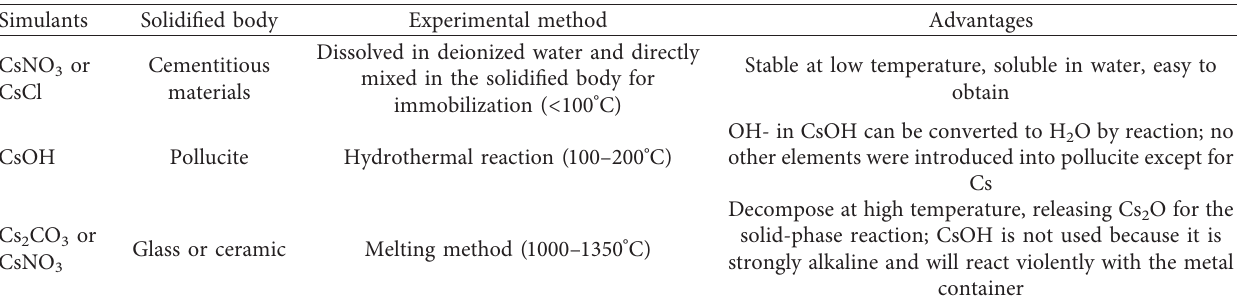
Table 4: The application conditions and advantages of the simulated 137 Cs.